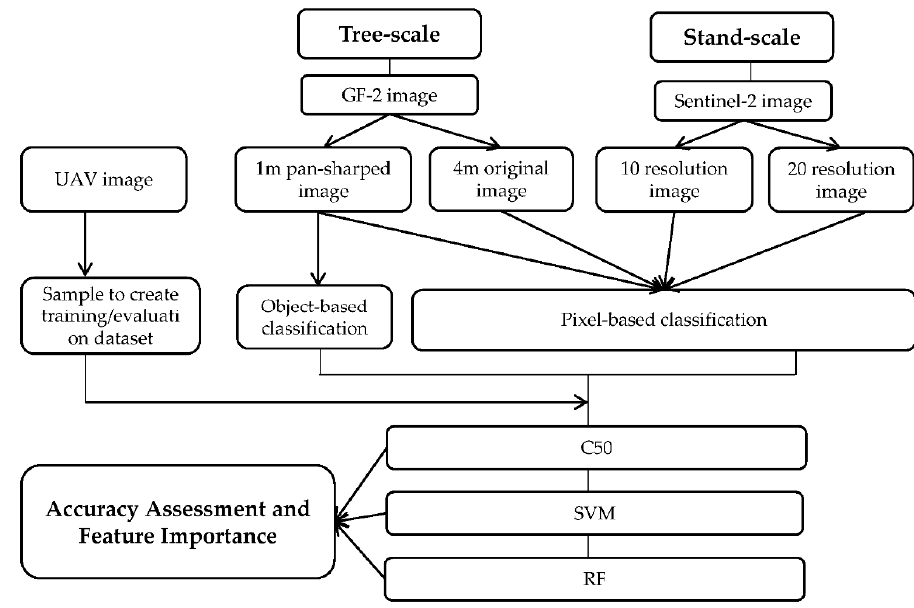
Figure 3. Flowchart of operations used to classify GF2 and S2 images. Table 3. All features extracted from GF2 and S2 images.